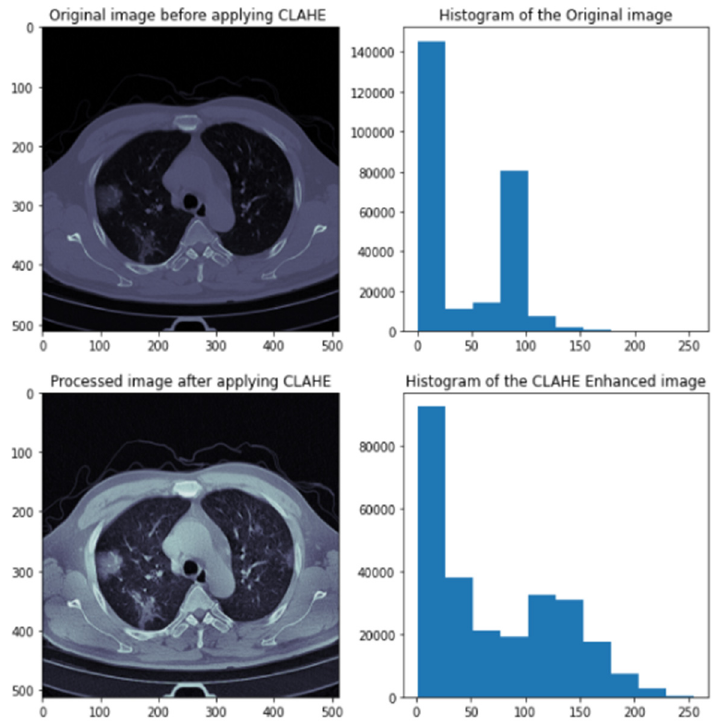
Figure 3. The impact of applying the CLAHE filter on an input chest CT scan.